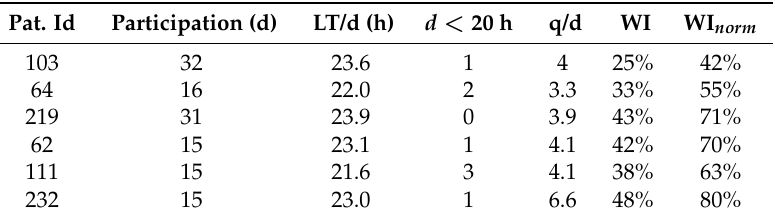
Table 5. Daily averages of retention features: LT/d—avg logging time per day; d < 20 h—nb. of days with less than 20 h logging time; q/d—avg nb. of answered questionnaires per day; WI—average wearability index; WI norm —WI normalised to a 16 h